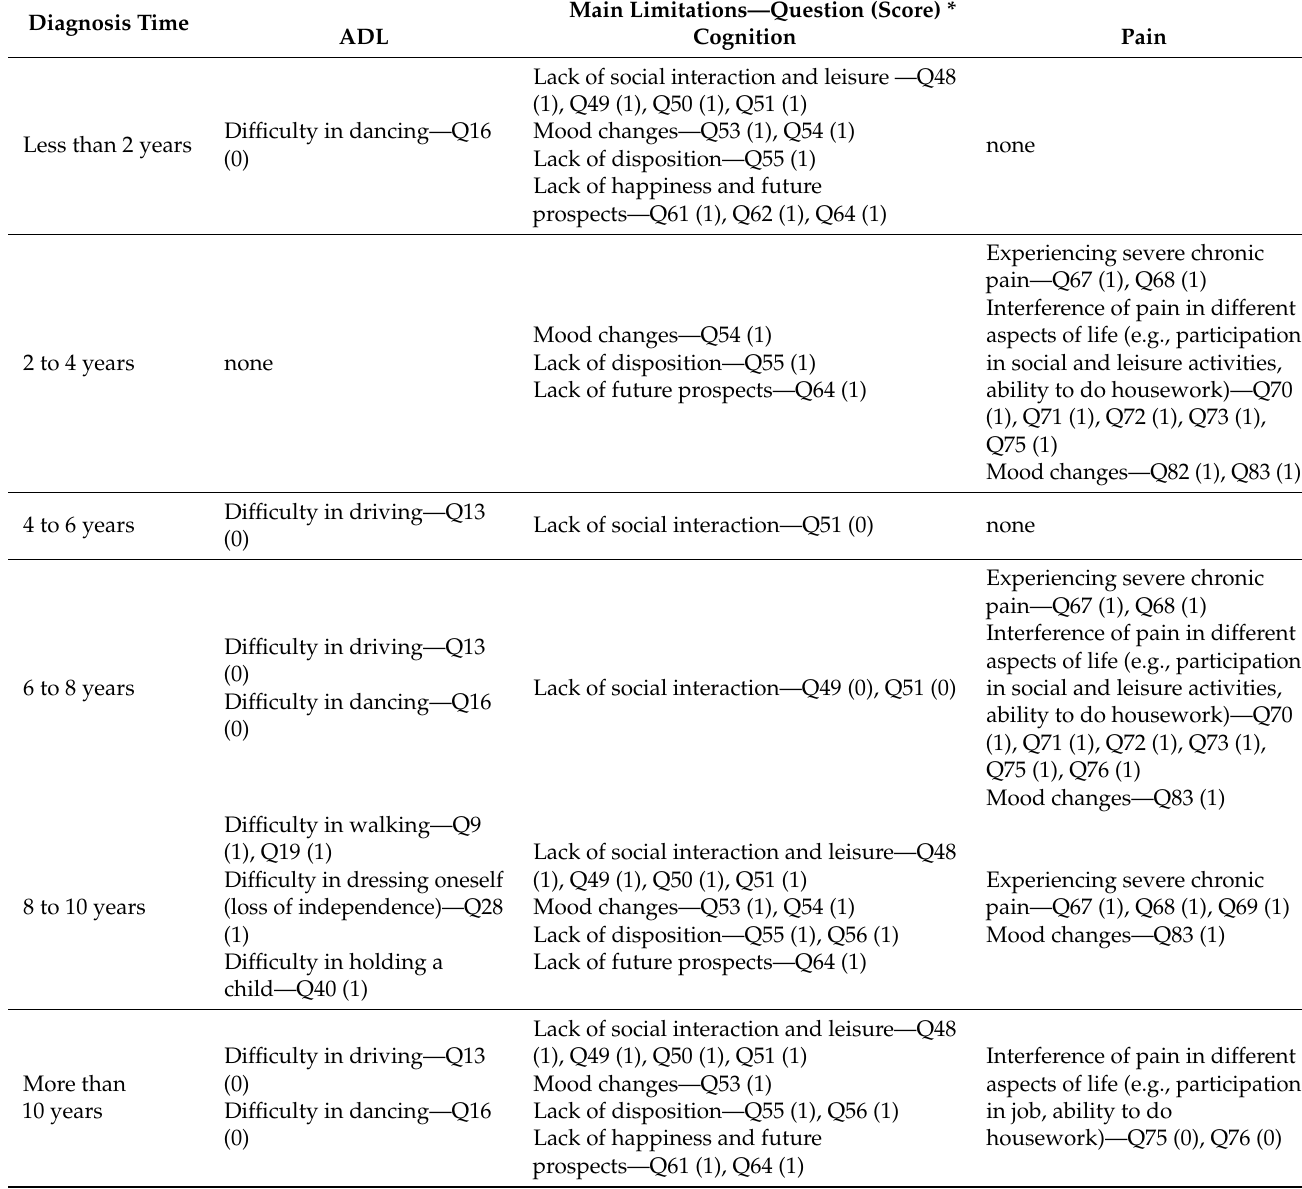
Table 5. Main motor, cognitive, and pain limitations of the groups defined by the diagnosis time of the